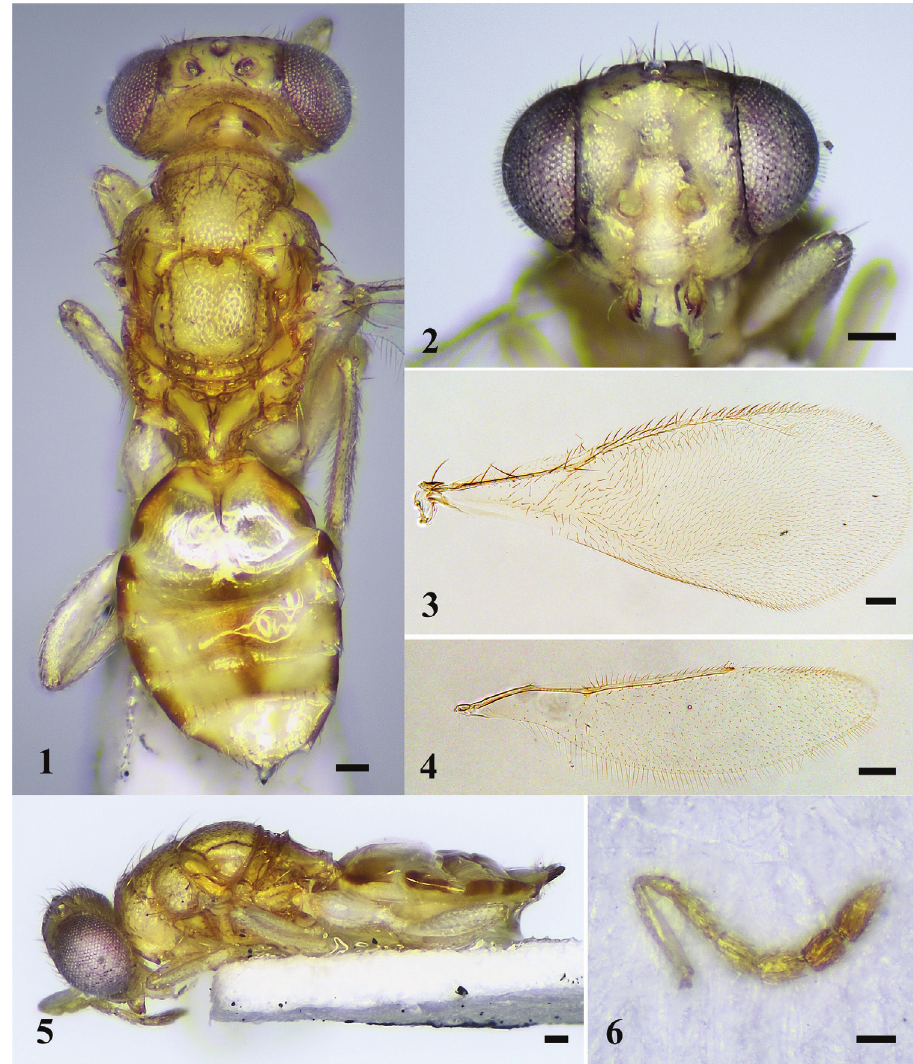
Figures 17–22. D. octoseta sp. nov., female, holotype 17 habitus in dorsal view 18 head in frontal view 19 fore wing 20 hind wing 21 habitus in lateral view 22 antenna. Scale bars: 100 following combination of characters: fore wing hyaline without infuscation (fore wing with brown infuscation a short distance below STV in D. kairali ); antenna with scape white, pedicel and F1–F3 pale yellow, clava brown except apex yellowish (antenna brownish black with scape and pedicel pale brownish yellow in D. kairali ); midlobe of mesoscutum with four pairs of long setae (three pairs of long setae in D. kairali ).